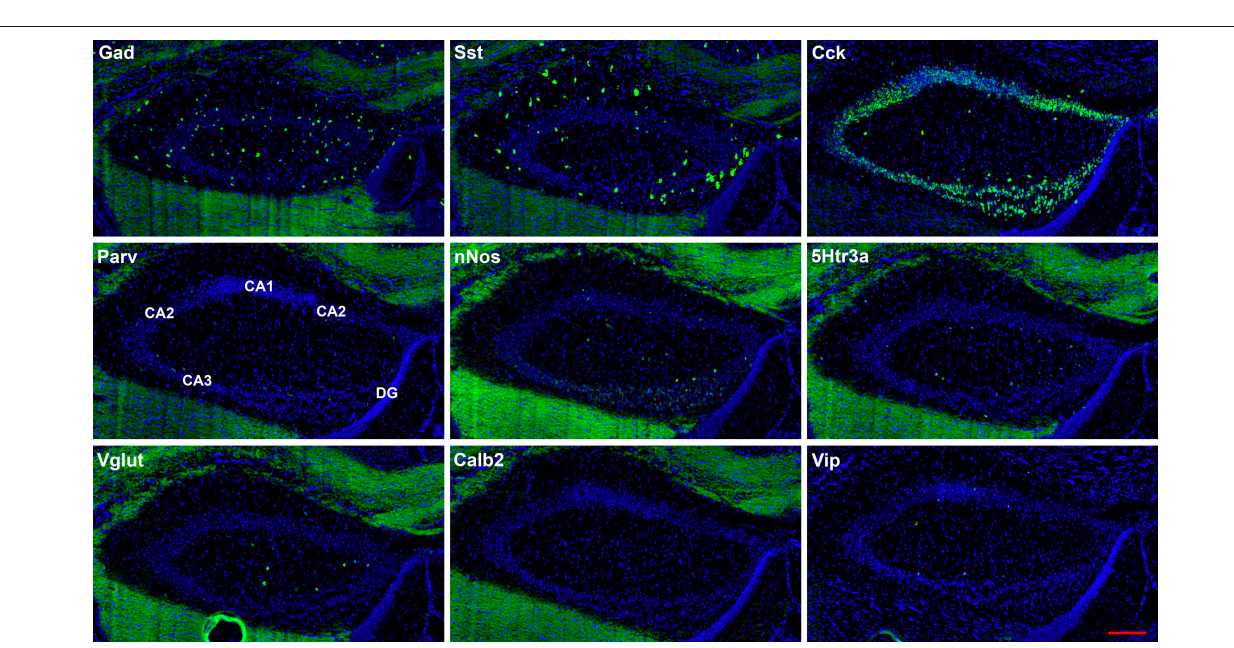
Frontiers in Molecular Neuroscience |